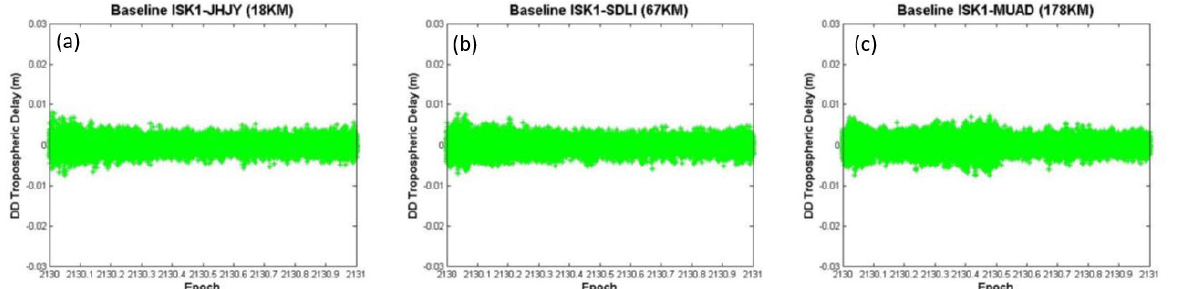
Figure 4. Dispersive medium of GPS distance-dependent errors for (a) short, (b) medium, and (c) long baselines.